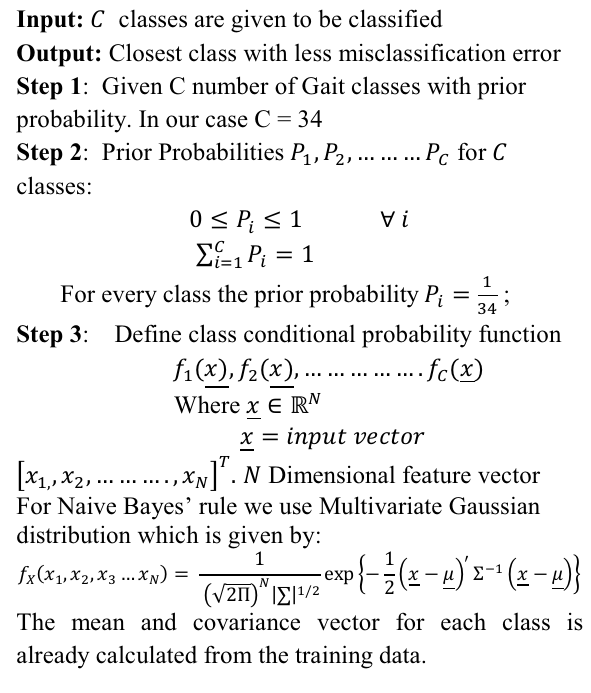
Fig.12. Description of Three Classification Techniques Chebychev, Minkowski, and Mahalanobis distances. A novel approach for classification has been proposed using polynomial based distance metric generation. A unique polynomial is used to represent the features of the subject at different speeds, then the minimum distance between the input test vector and generated feature vector is found using various distance based metrics. It has been observed that the best fit for each feature of a given subject was satisfied by a polynomial of degree 5. Therefore, we have obtained 34 different polynomials for each different person. The pictorial representation of three classifiers is shown in Fig 12. The classification algorithms are described as follows. Algorithm 2: Bayes’ Decision Rule for Classification